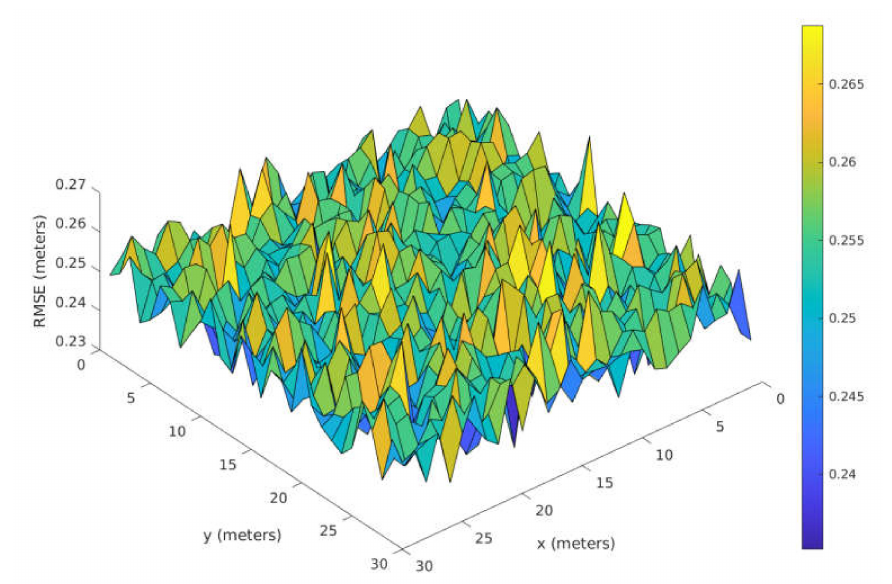
Figure 5. RMSE of the distance calculated from RTT measurements for the IEEE 802.11mc reference station. AP fixed at (15,15) and a sample-set of length